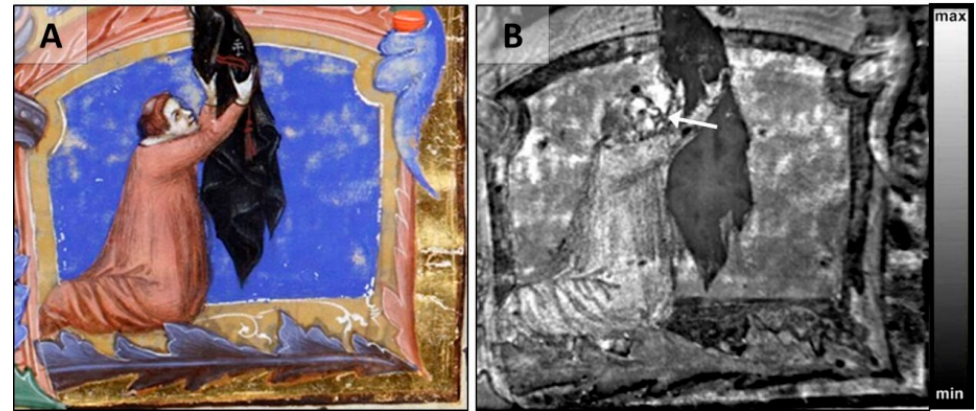
Figure 11. Liber Regulae S. Spiritus De Saxia, XIV century, Archivio di Stato di Roma . ( A ) Photograph of the illumination of folio 239 verso ; ( B ) thermogram showing a pentimento (indicated by the arrow). Damaged Surface